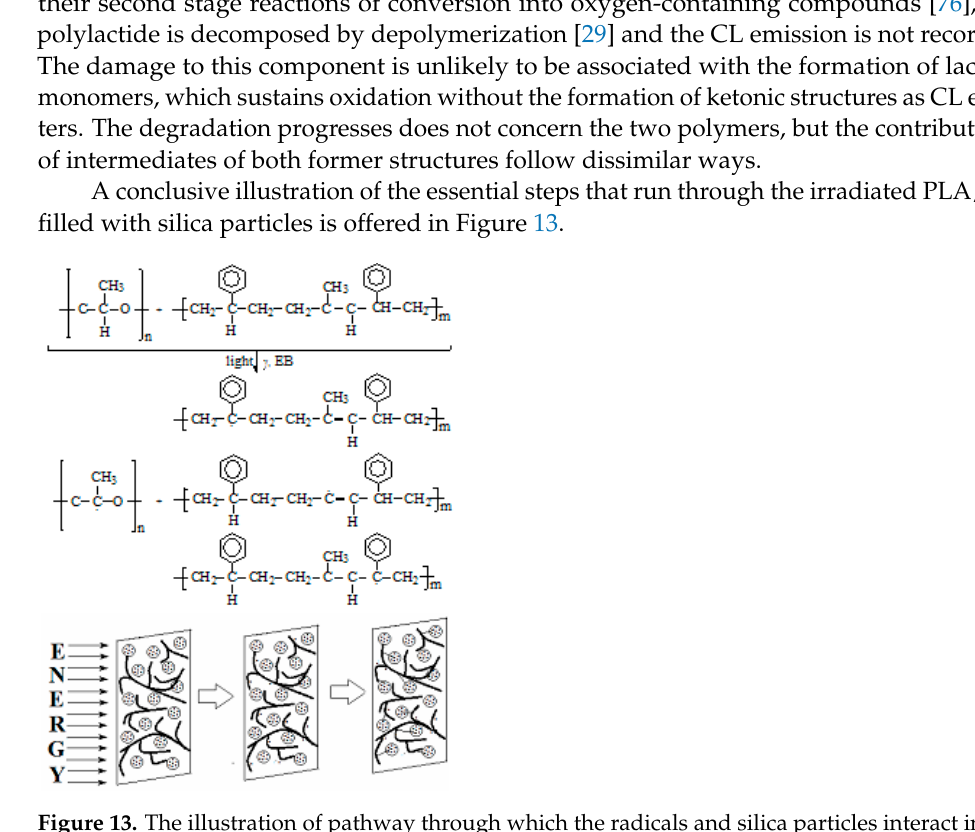
Figure 13. The illustration of pathway through which the radicals and silica particles interact in the PLA/SIS samples. PLA/SIS